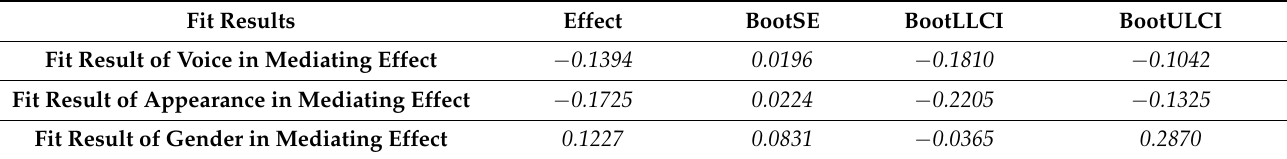
Table 3. Fit result of the variables in the mediating